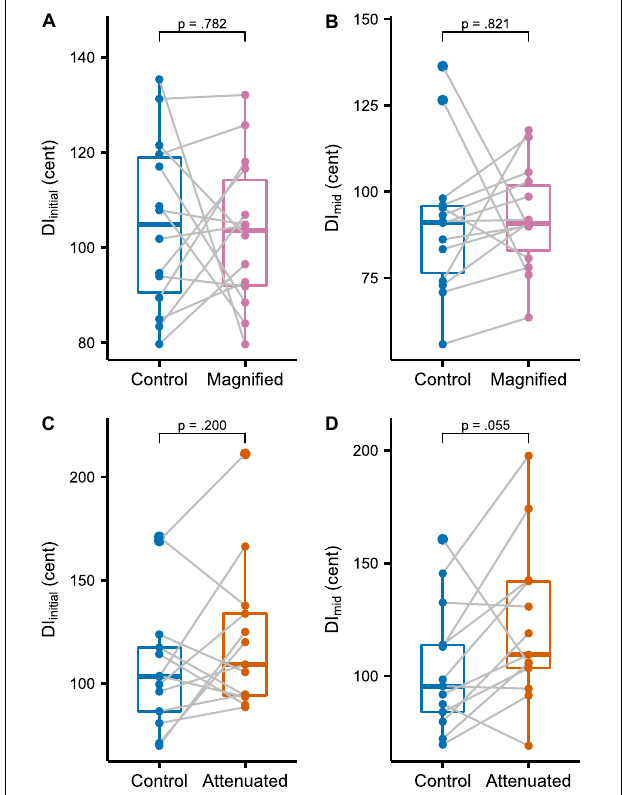
FIGURE 3 | (A,C) Boxplots with symbols depicting each participant’s average DI initial for the entire Variability task in Control and Magnified or Control and Attenuated conditions. (B,D) Boxplots with each participant’s average DI mid for the entire Variability task in the same